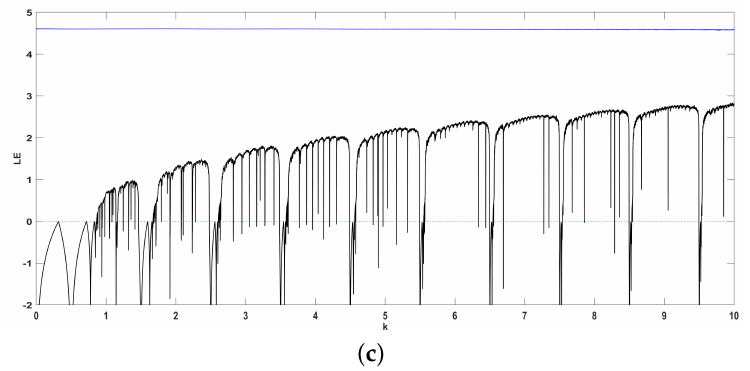
Figure 6. Bifurcation diagrams for ( a ) the sine map (24) and ( b ) the modified sine map (25) with respect to parameter k , for a = 100, N = 1. ( c ) LE of the sine map (24) (black) and modified sine map (25) (blue).